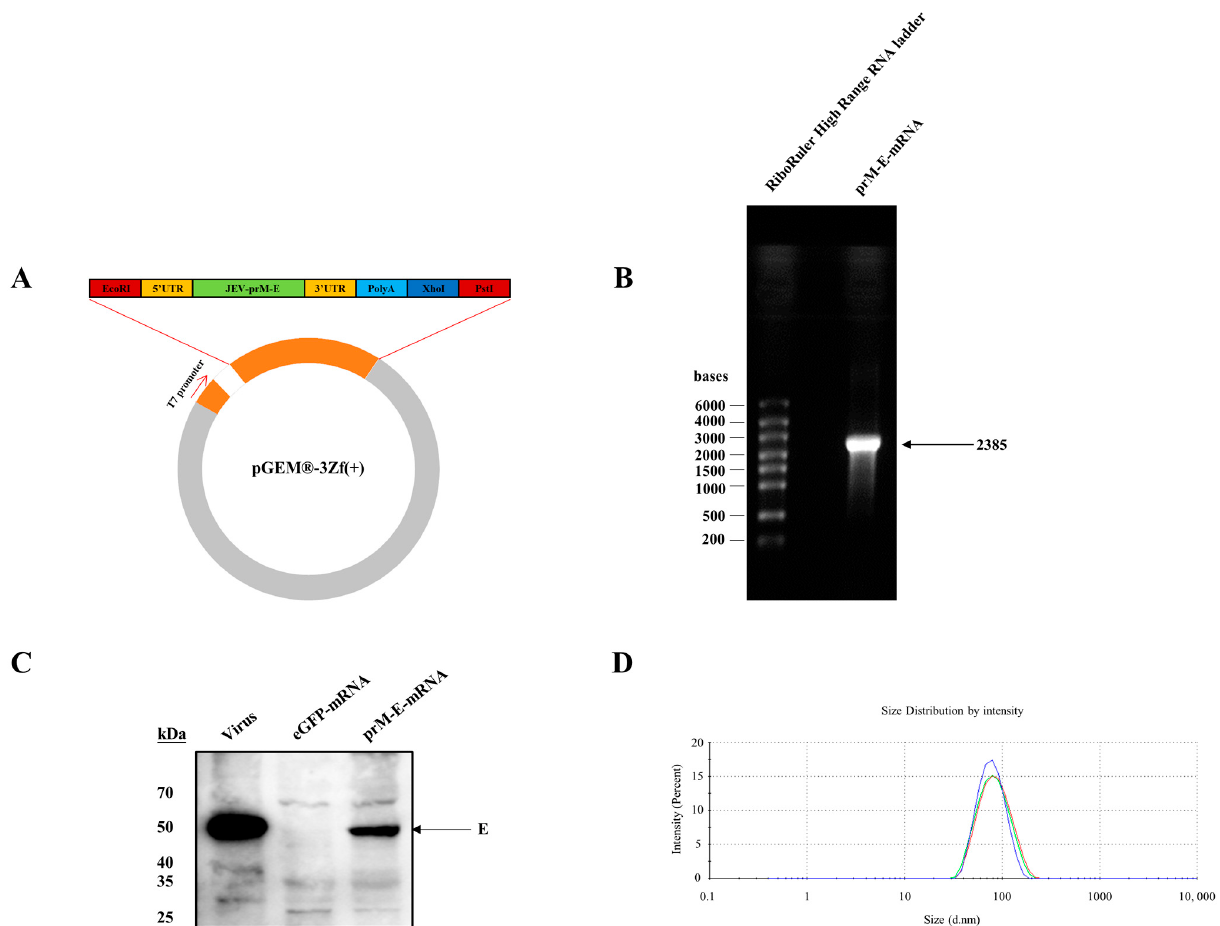
Figure 1. Construction and expression of mRNA-prM-E. ( A ) Characterization of vectors for in vitro transcription. (B ) mRNA-prM-E was run in the 1% formaldehyde denaturing gel (RNase-free). ( C ) HEK-293T cells were transfected with the mRNA-prM-E, and lysate was analyzed by Western blotting with a monoclonal antibody 1H10 against the JEV E protein. The pcDNA3.1 plasmid encoding prM-E and JEV were used as the positive controls. ( D ) The particle size of the LNP-mRNA was measured three times using a Zetasizer spectrometer indicating an average size of approximately 80 nm.